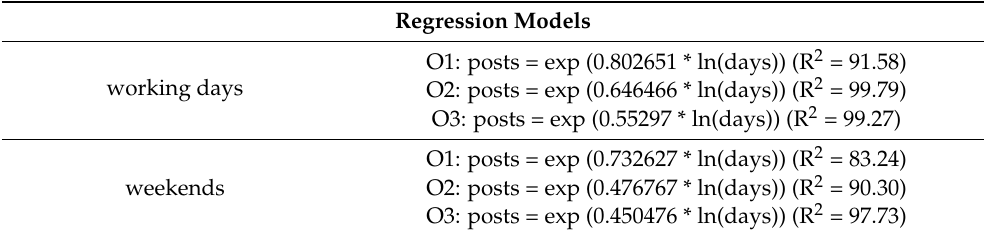
Table 2. Linear regression model for posts during working days and weekends over each observation. Regression Models